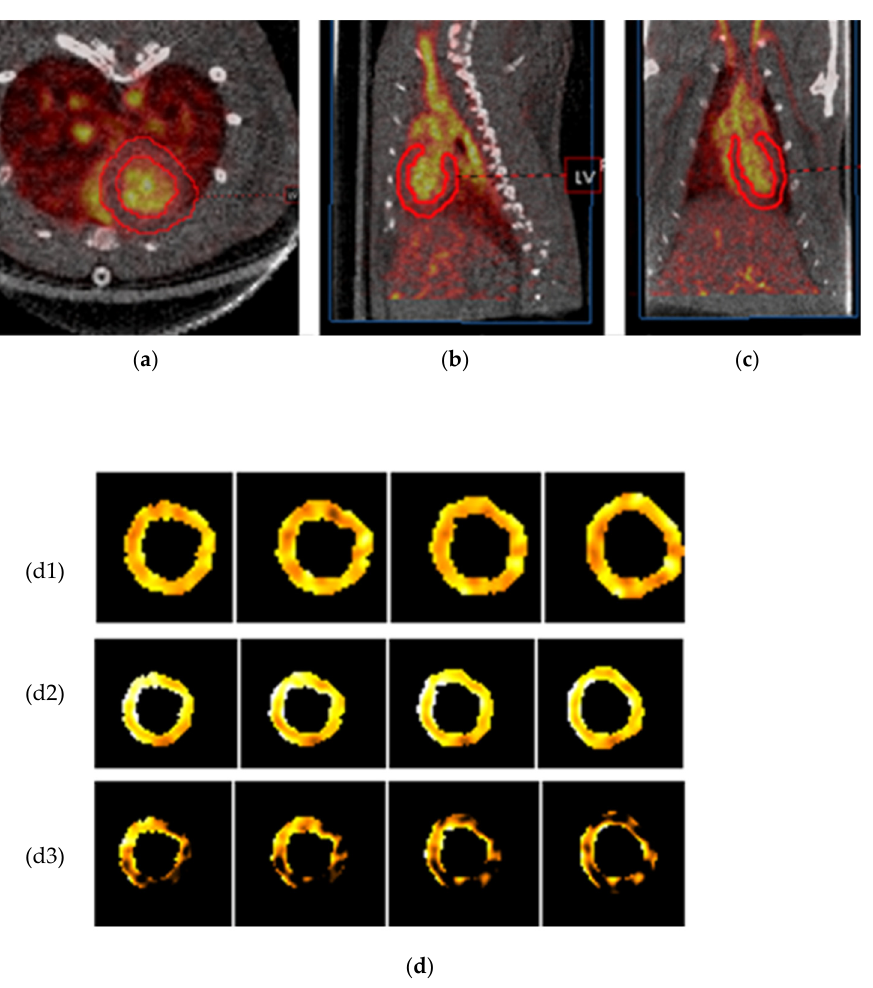
Figure 3. Volume segmentation of the left ventricular (LV) myocardium of a representative rat on FDG RBC PET/CT images. ( a – c ) Axial, coronal, and sagittal (respectively) segmentation of normal rat myocardium. Manual segmentation of the left ventricle is depicted by a red outline. ( d ) Four consecutive cardiac short axis views of a rat left ventricular wall under rest conditions ( d1 ), vasodilatory stress conditions ( d2 ), and the net activity difference between stress and rest conditions after digital subtraction imaging ( d3 ). Total rats = 5.